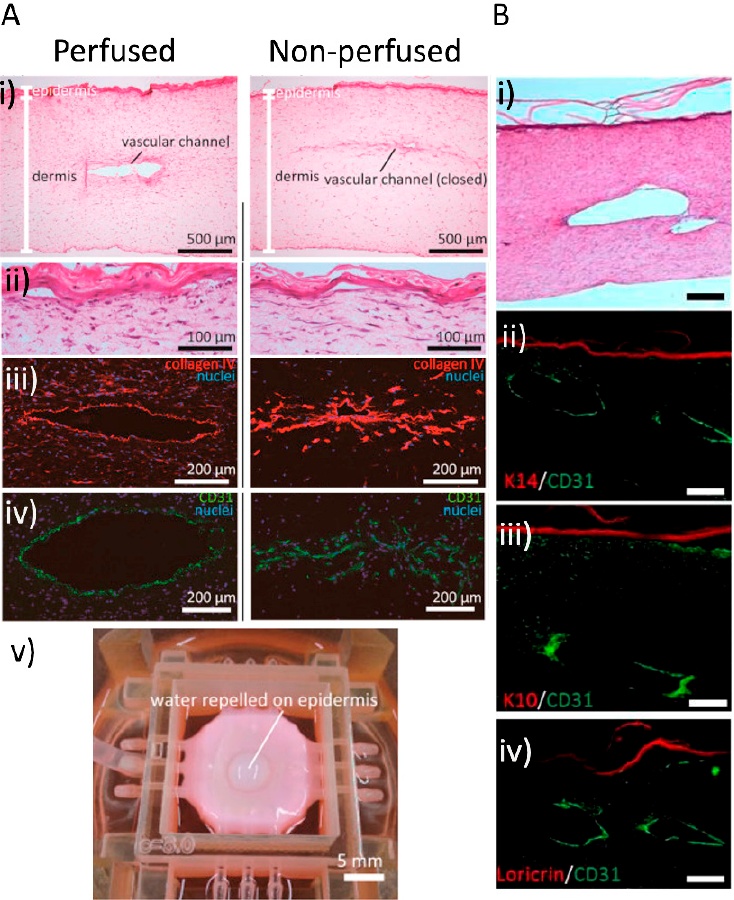
Figure 5. Vascular channels in bioprinted skin constructs. ( A ) Mori and colleagues’ work: skin integrated with perfusable vascular channels on a chip [109]. Histological analysis and barrier function assessment. Both perfused and nonperfused samples were cryosectioned for evaluation (i) Hematoxylin-eosin (H&E)-stained sections of perfused and nonperfused skin equivalents. (ii) Magnified images of the H&E-stained epidermal layers. (iii,iv) Immunostained vascular channels: (iii) Immunostaining with HUVEC marker CD31 and (iv) basal membrane protein (type IV collagen). (v) Barrier function evaluation by observing the repellence of water by the epidermal layer. ( B ) Abaci and colleagues’ work: human skin constructs with spatially controlled vasculature using primary and iPSC-derived endothelial cells. (i) Image showing H&E staining of the bioprinted skin equivalent showing normal skin physiology, and the lumen of the vascular channel is exposed. (ii,iii,iv) Im- munofluorescent staining of histological sections of vascularised human skin equivalents generated using iPSC-derived endothelial cells. The sections were immunolabeled with K10, K14 and loricirin (red) and CD31 (green) to evaluate epidermal integrity and endothelial coating in the microchannels. Scale bars: 250 µ m. Images reproduced with permission from Mori et al. and Abaci et al.